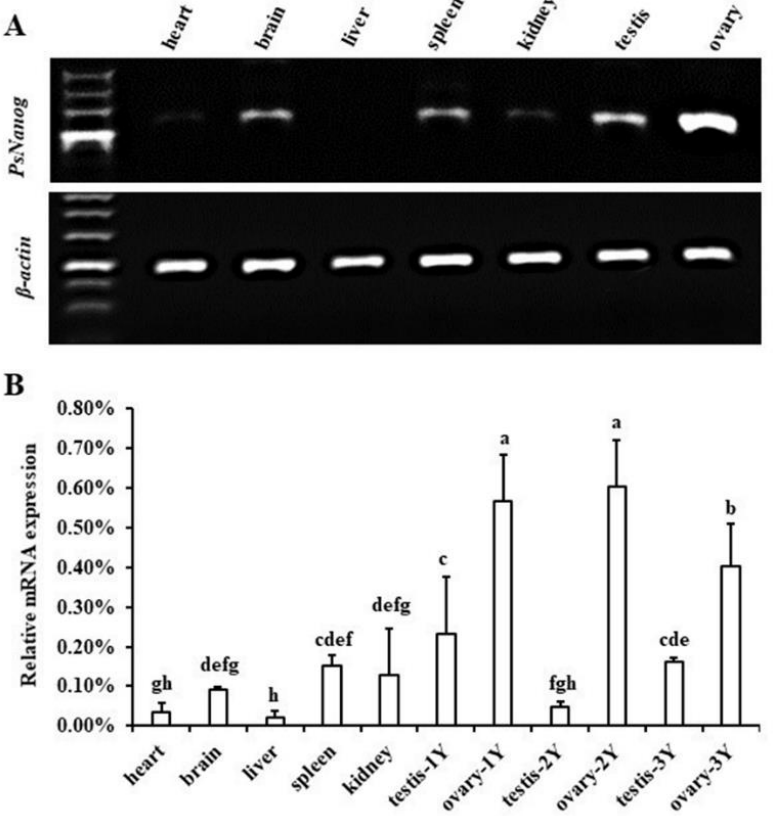
Figure 3. Transcription profile of PsNanog mRNA in adult tissues of Pelodiscus sinensis by RT-PCR ( A ) and RT-qPCR ( B ). ( A ) The β -actin was amplified as the internal control. The adult tissues were used as indicated. The PsNanog mRNA is rich in ovary. ( B ) X-axis represents different tissues, including heart, brain, liver, spleen, kidney, ovary and testis of different ages. Y-axis indicates the relative expression levels (%) of genes. β -actin was used as normalization factor of RT-qPCR. Data were presented as means ± standard deviations (SD). Different lowercase letters indicated the significant difference at p < 0.05 by using the method of Least Significant Difference ( LSD